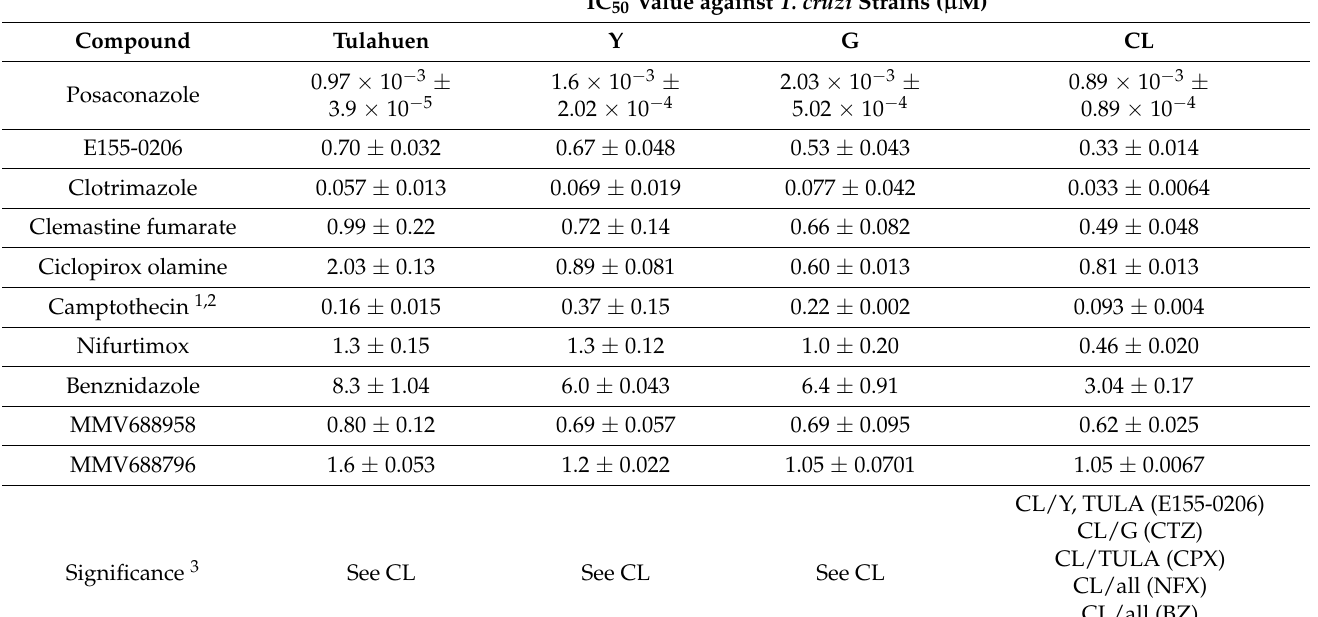
Table 2. IC 50 values of compounds with known activity against T. cruzi determined after 72 h incubation with different strains: the cytochrome P450 inhibitors posaconazole, E155-0206 and clotrimazole; the cell cycle inhibitor camptothecin; clemastine fumarate and two compounds from the MMV Pathogen Box collection (unknown MOA against T. cruzi ) and the drugs used to treat Chagas disease (nifurtimox and benznidazole). 1 Indicates compounds that did not clear 100% of parasites from host cells, across all parasite strains, with ≤ 95% maximum achievable activity (E max ). 2 There was a 30–50% reduction in host cell numbers at the E 3 Significance = a max , for camptothecin. significant difference in the IC 50 value of compounds between strains ( p < 0.05), shown where the IC 50 for the strain is 2-fold less than